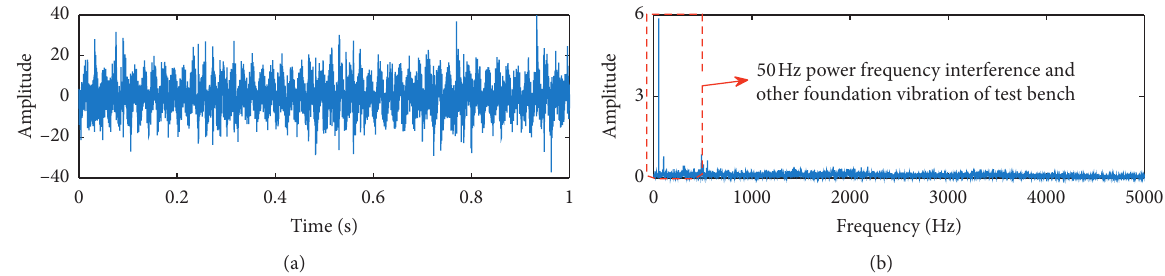
Figure 23: (a) Bearing roller fault signal and (b) its Fourier